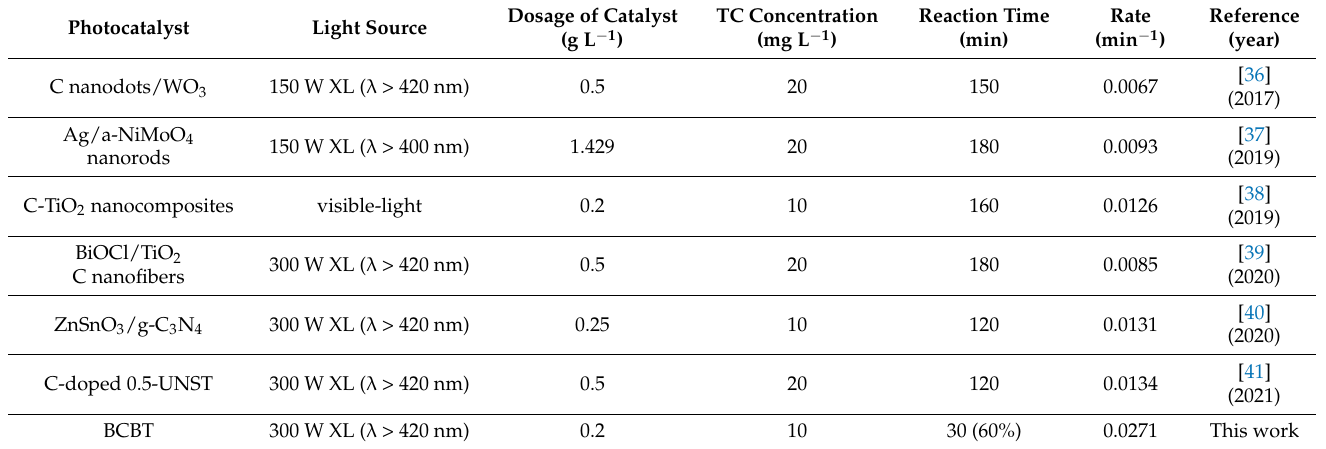
Table 1. The comparison of photocatalytic degradation activities of different photocatalysts for